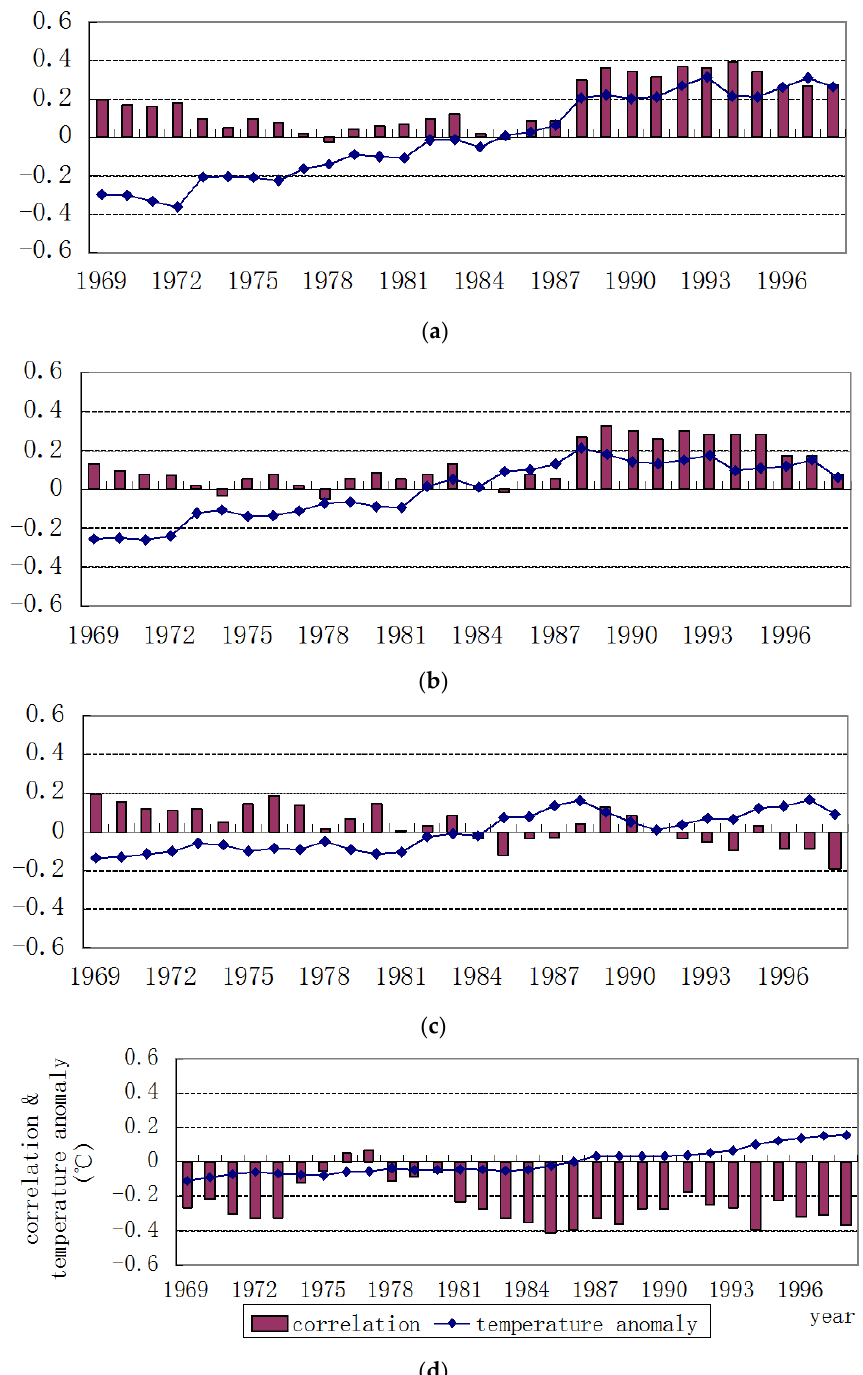
Figure 7. The 21-a moving correlation (histograms) between the rainfall in PFSSC and the equatorial Pacific Ocean temperature in January-March and the 21-a moving average anomaly of the Pacific Ocean temperature (line, unit: °C). The NINO1 + 2 region as ( a ), NINO3 region as ( b ), NINO4 region as ( c ) and the warm pool region as ( d ).